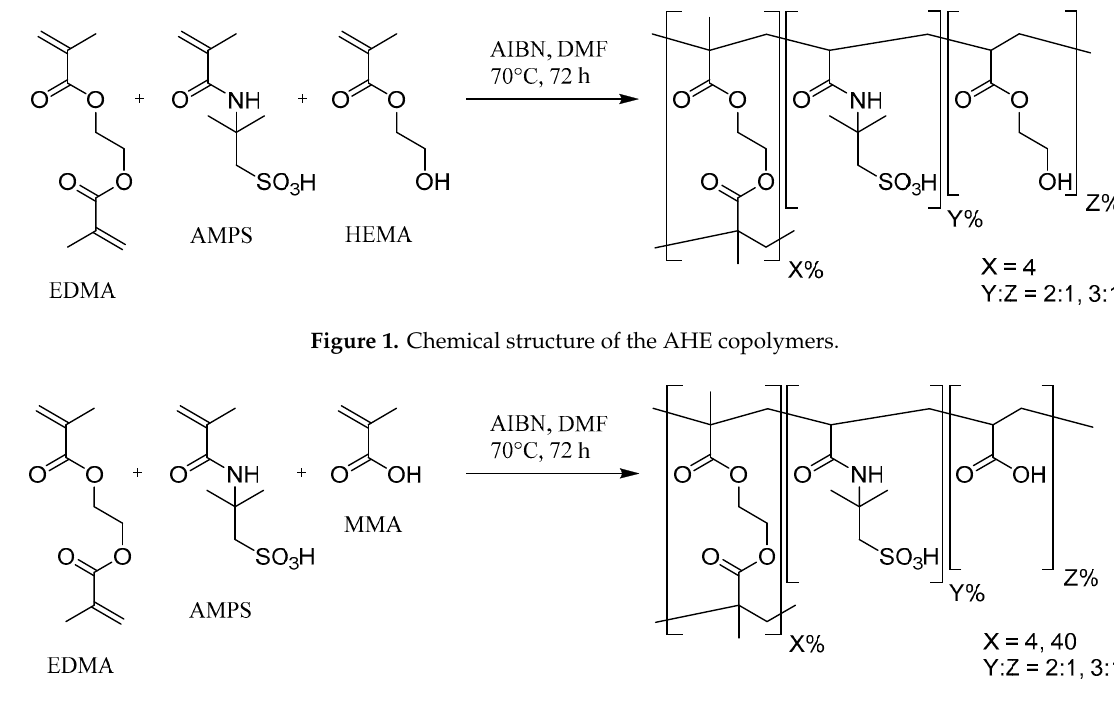
Figure 2. Chemical structure of the AME copolymers.